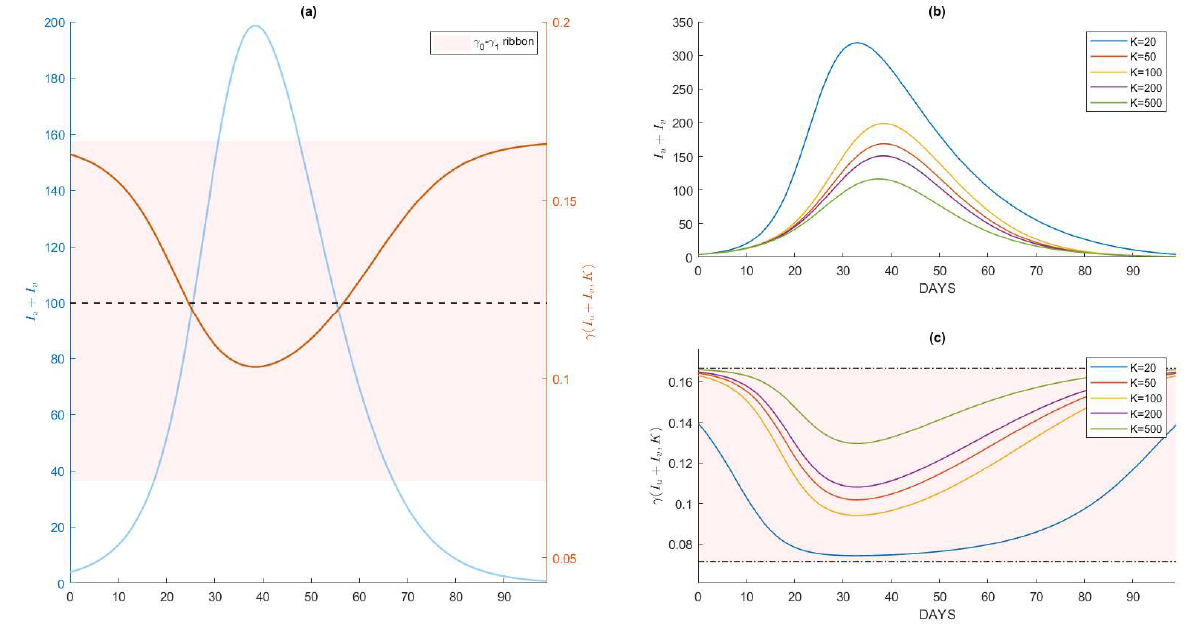
Figure A2. Numerical simulations under different values of healthcare capacities: ( a ) comparison between the dynamics of active cases and the rate of recovery using the same parameters as used in Figure A1, ( b , c ) sensitivity analysis of I u + I v and the rate of recovery γ under different value of healthcare capacity K.